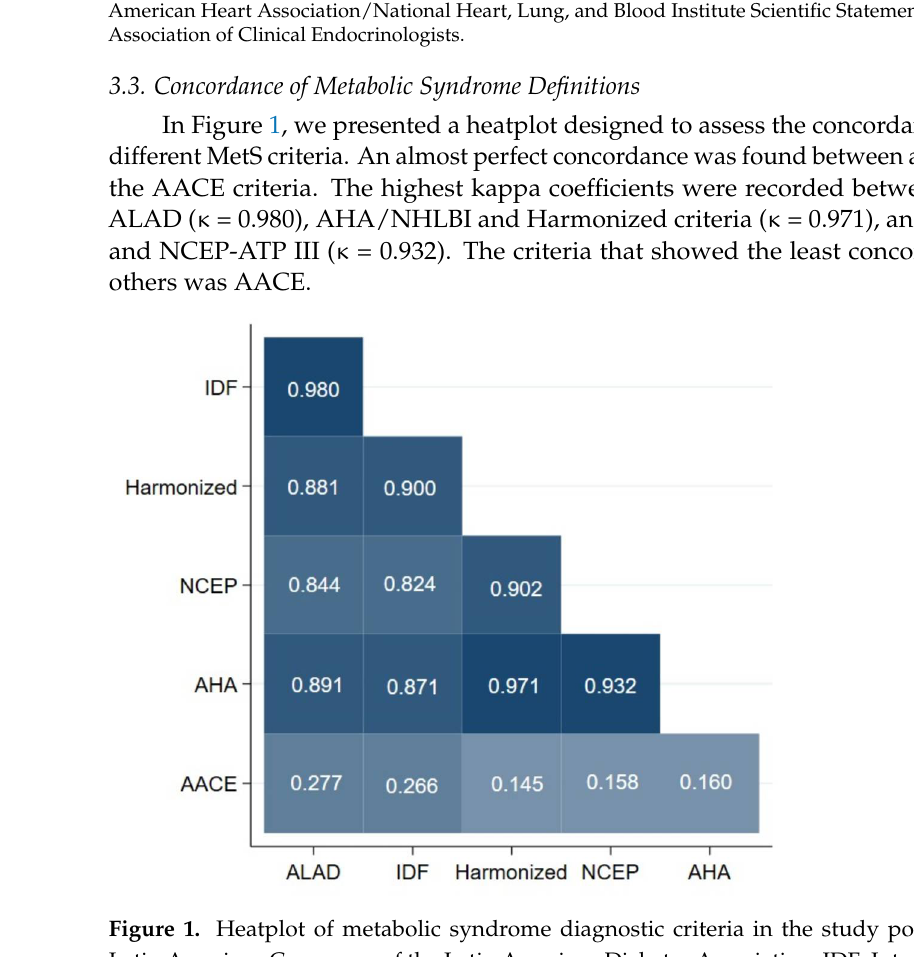
Figure 1. Heatplot of metabolic syndrome diagnostic criteria in the study population.